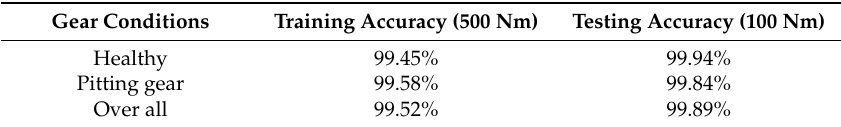
Table 7. Detection results at mixed rotating speeds (trained with heavy loading samples and tested with light loading samples).